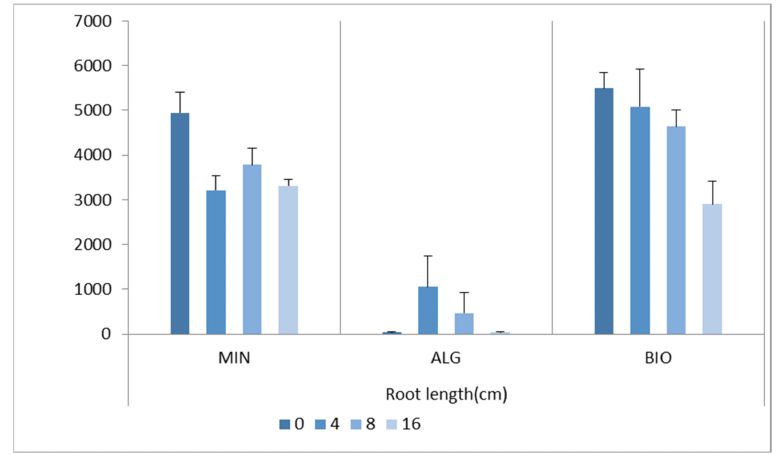
Figure 4. The effects of salinity stress and fertilizer types on root length during the early growth stage (7 weeks) for Rehan barley cultivar (MIN: mineral fertilization, BIO: biochar with mineral fertilization, ALG: dried algae biomass powder from freshwater, 0, 4, 8, 16 mS/cm EC are the salinity concentrations in soil). The mean value and standard deviation are shown.